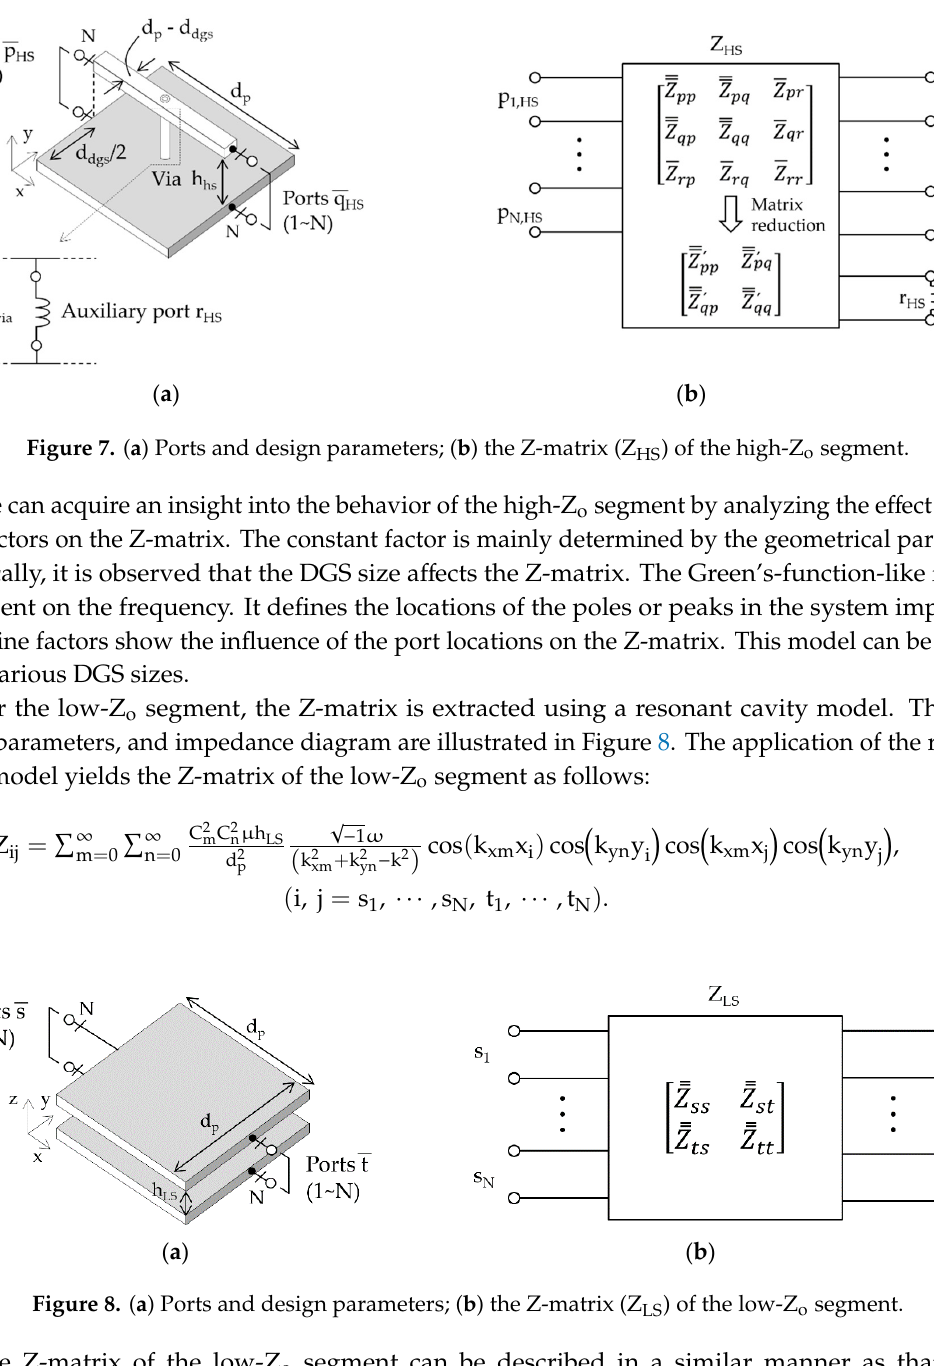
LS ) of the low-Z o